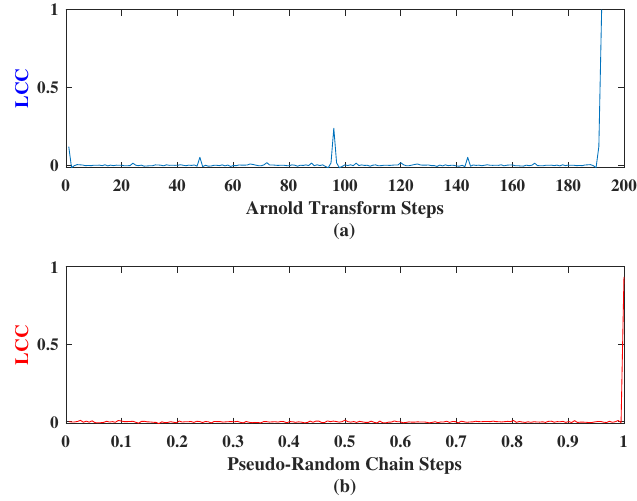
Figure 5. Linear correlation coefficient (LCC) comparison chart.